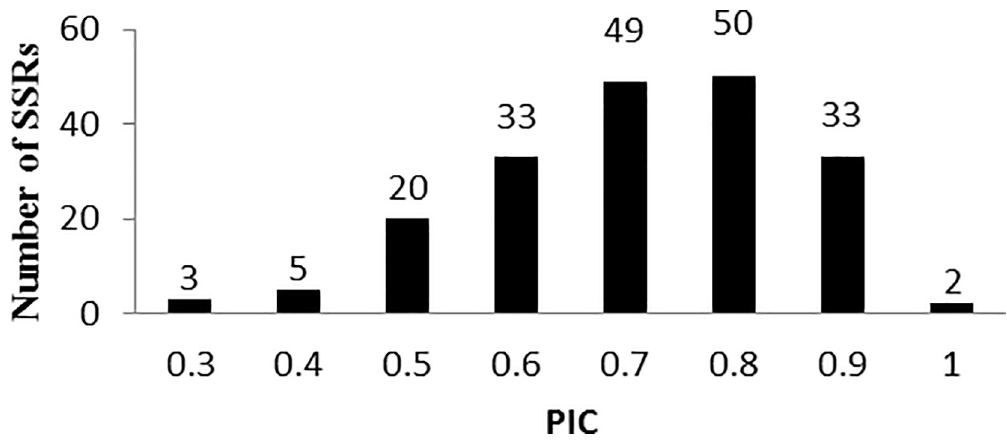
Fig 3. Histogram of PIC distribution of 195